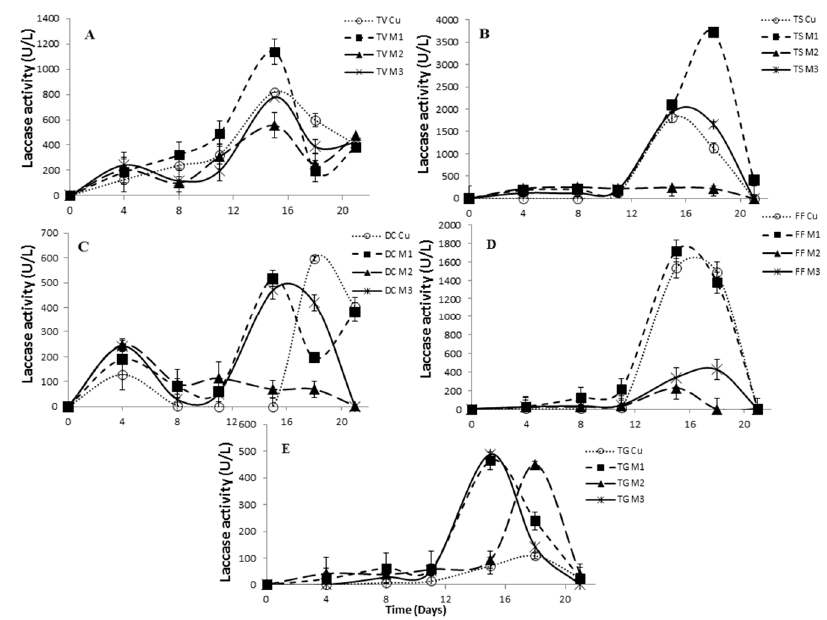
Figure 4. Evaluation of laccase activity of TV, Trametes versicolor ( A ); TS, Trametes suaveolens ( B ); DC, Daedaleopsis confragosa ( C ); FF, Fomes fomentarius ( D ); and TG, Trametes gibbosa ( E ); with a 0.5 mM concentration of inducers. Standard deviation lines represent the variation of the mean activity value obtained from three replicate cultivations.